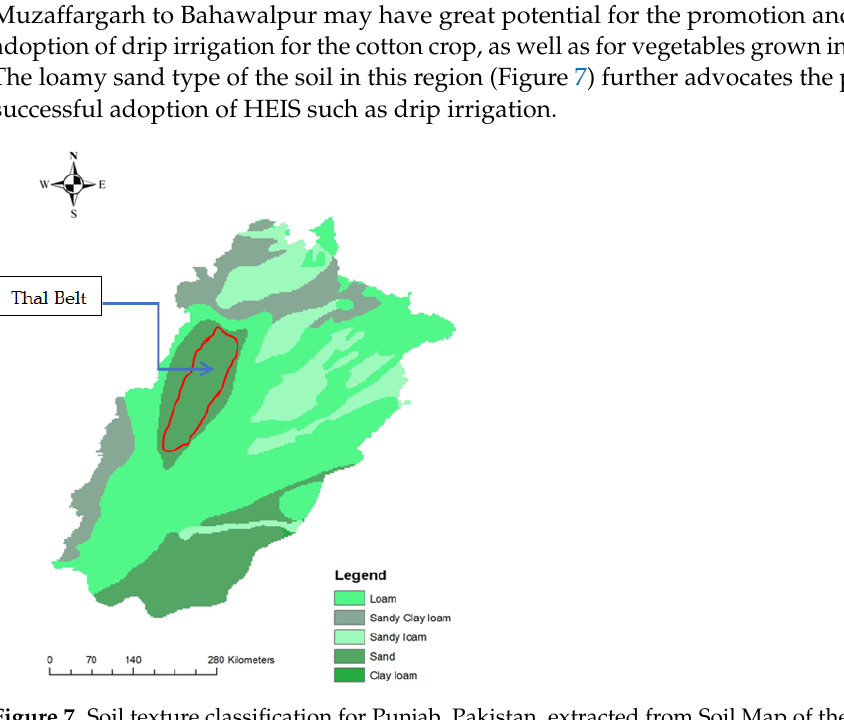
Figure 7. Soil texture classification for Punjab, Pakistan, extracted from Soil Map of the World [50].